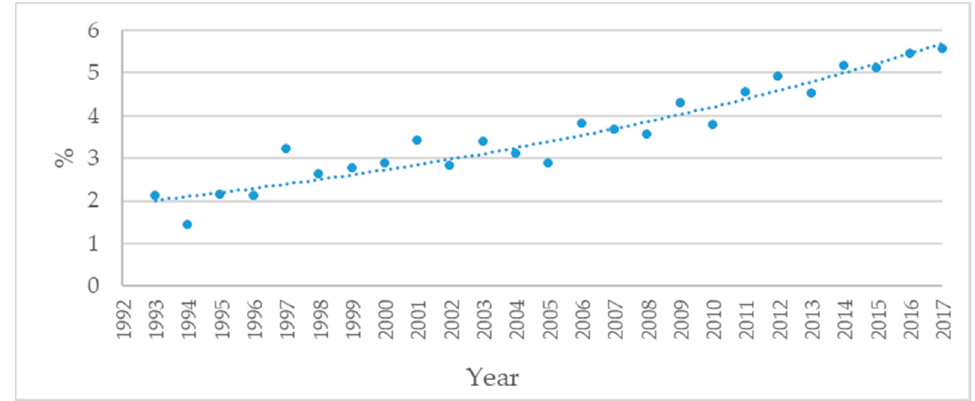
Figure 2. Percentage of Slovak men with weight more than 110 kg.